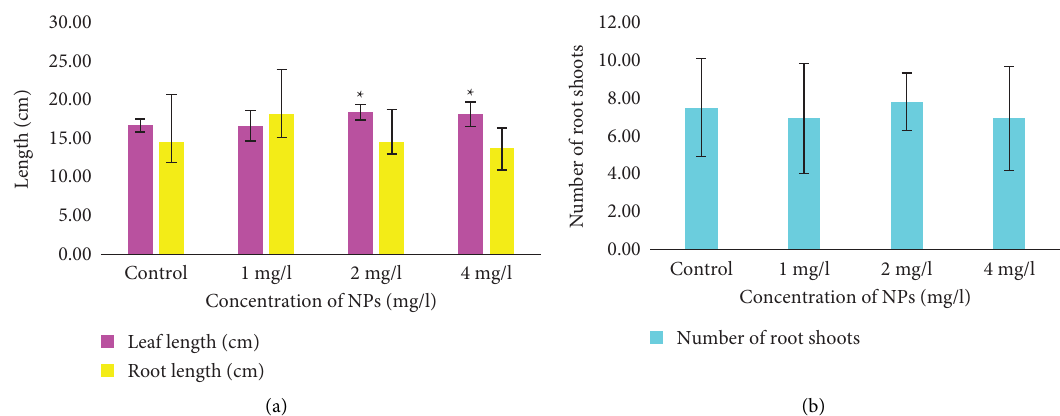
Figure 2: Leaf and root lengths (a) and number of roots (b) in common wheat ( Triticum aestivum L.) after 15 days of treatment with Fe nanoparticles. Te values are the means of three replicates with a standard deviation. ∗ indicates a statistically signifcant diference compared to the control ( P < 0.05).